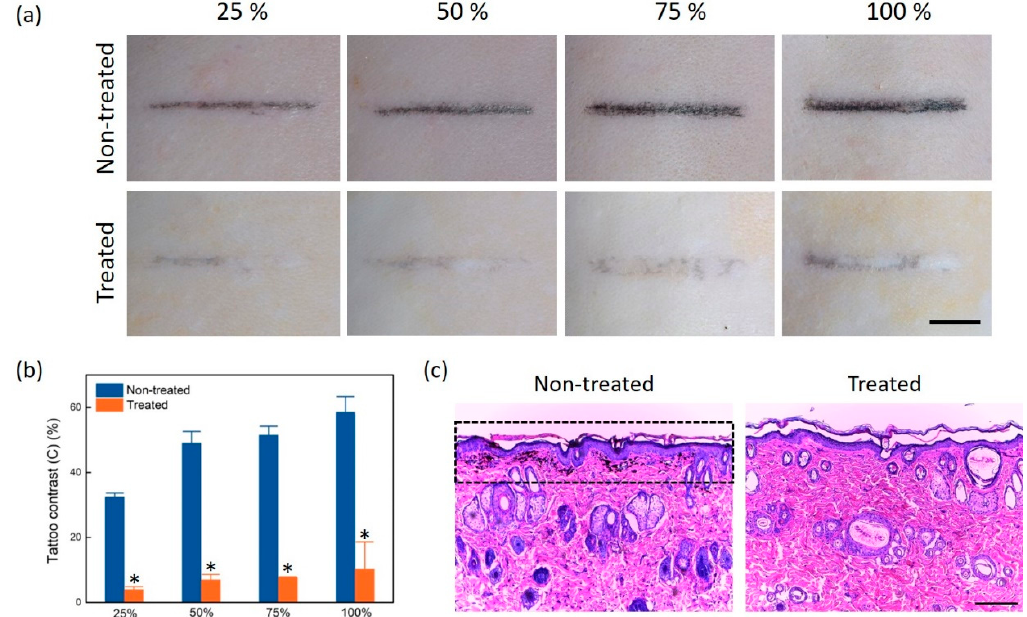
Figure 4. Comparison of non-treated (week 0) and laser-treated tattoo samples (week 6): ( a ) top surface images (scale bar = 5 mm), ( b ) tattoo contrast for four different concentrations measured from Figure 4a (* p < 0.05 vs. non-treated), and ( c ) histology images of non-treated (week 0) and treated skin tattoo (concentration = 75%; week 6). Note that the dashed lines represent the ink particles injected into the dermis of non-treated tissue (scale bar = 200 μ m; × 100).